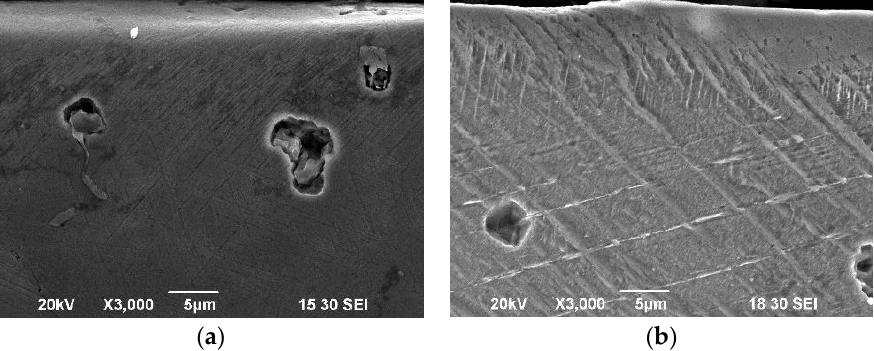
Figure 4. Wear surface microstructure, 0.29%V: ( а ) as cast; ( b ) after heat treatment.